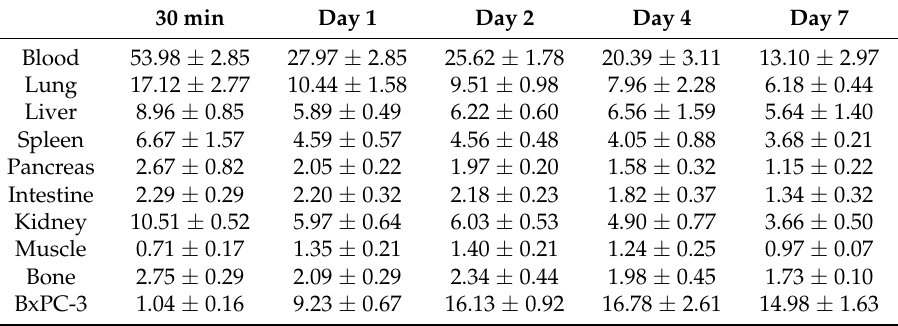
Table 1. Biodistribution of 111 In-labeled anti-CD147 antibody 059-053 in mice bearing BxPC-3 tumors.